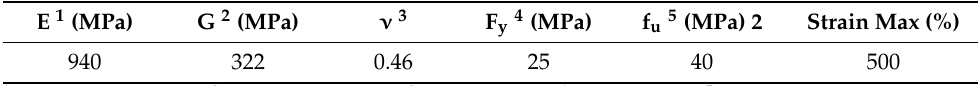
Table 2. Mechanical properties for UHMWPE liner.